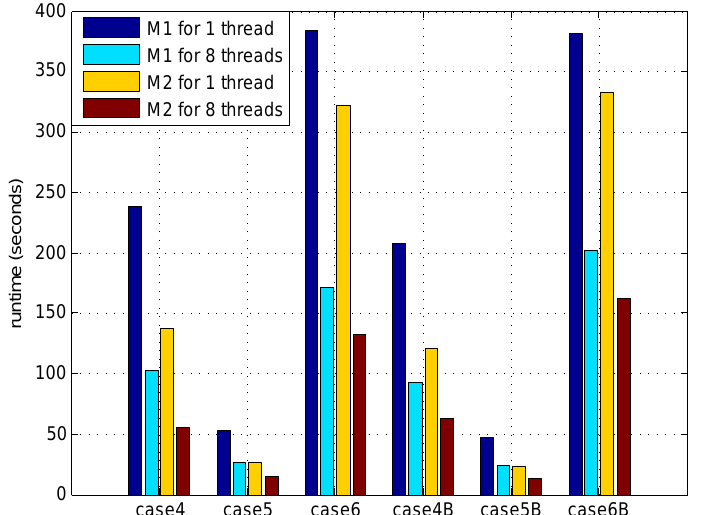
Figure 8. Comparisons of the 3D, BFS-based approximate optimal addressing algorithm